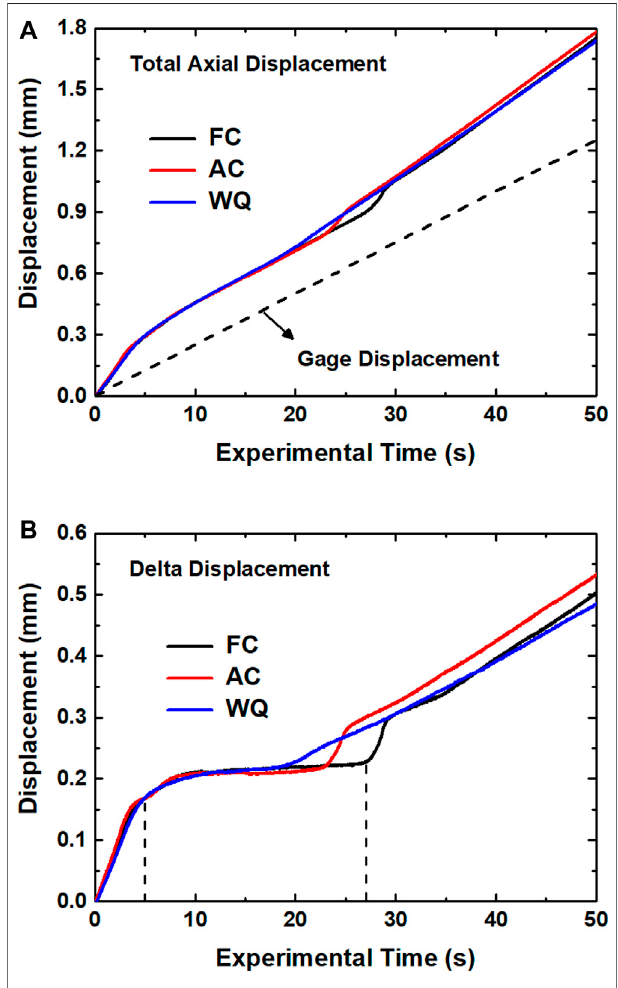
FIGURE 4 | (A) The evolutions of total displacement and (B) delta displacement (the displacement out of the gauge section) of the Fe-18Mn- 0.6C-1.5Al twinning-induced plasticity (TWIP) steel specimens annealed at 700 ° C for 5 min with three different cooling conditions. Dashed line is a gauge displacement. The delta displacement is the difference between the total and gauge displacement